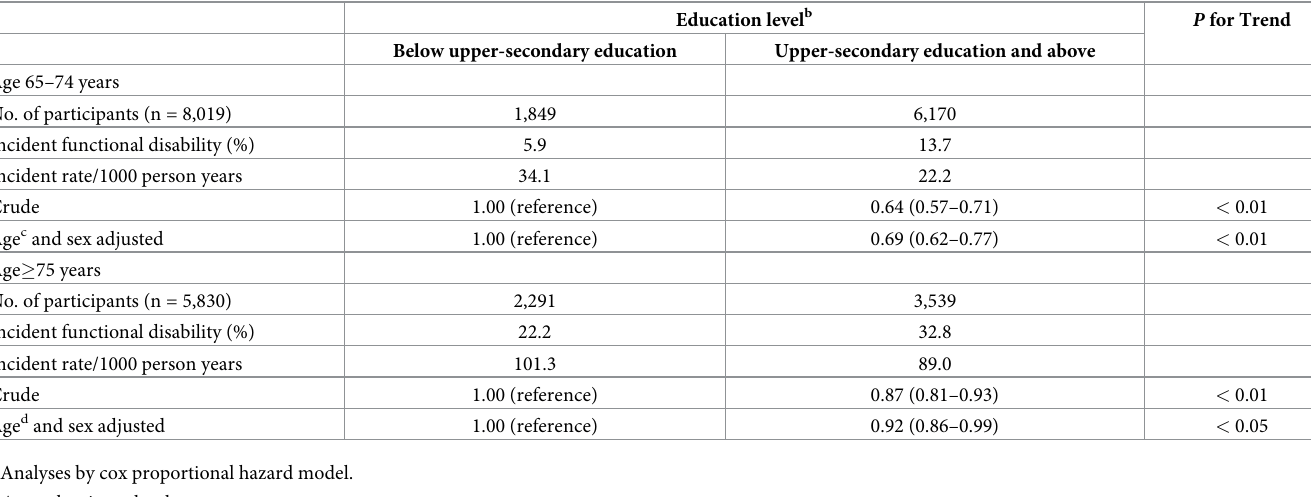
Table 4. Relationship between education level and incident functional disability by age. Ohsaki city, Japan, 2006–2015 (n = 13,849) a